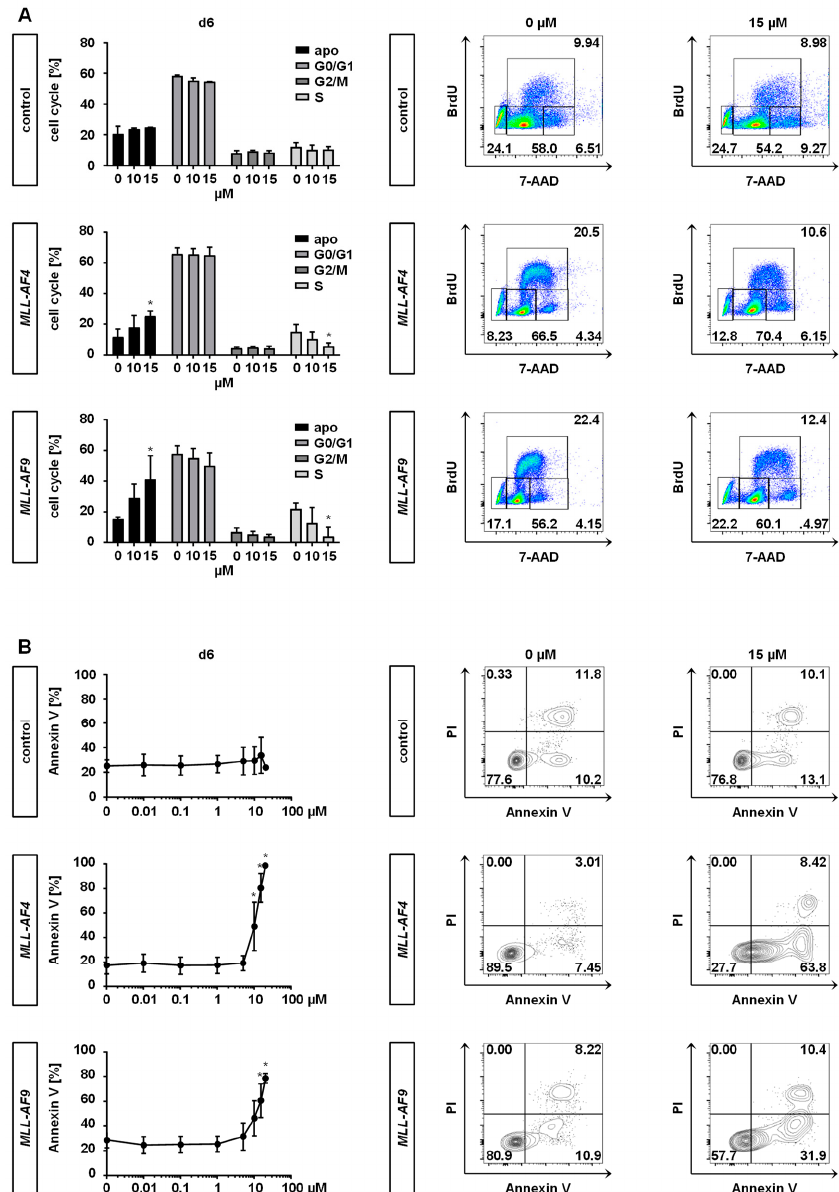
Figure 3. Inhibition of MAT2A reduces DNA synthesis and induces apoptosis of MLL r cells. MLL-AF4/-AF9 or culture-expanded CD34 + huCB control cells were treated with PF-9366 (10 or 15 µM) or vehicle (DMSO) for 6 days. ( A ) Pooled data (left) and representative (right) cell cycle analyses of single cells from three biological replicates ( n = 3) performed in technical triplicates are shown. Data were acquired using BrdU staining and flow cytometry. Bars represent the mean. Error bars indicate SD. One-way ANOVA was used with Dunnett correction: *, p < 0.05. (B) Annexin V staining revealed translocation of phosphatidylserine to the outer leaflet of the plasma membrane in apoptotic cells. Pooled (left) and representative (right) data from three biological replicates ( n = 3) performed in technical triplicates are shown. Dots represent the mean. Error bars indicate SD. One-way ANOVA was used with Dunnett correction: *, p <